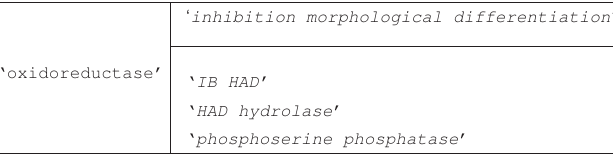
TABLE 1 | Synteny phrases for linguistic search for Ms1 RNA in Streptomyces .